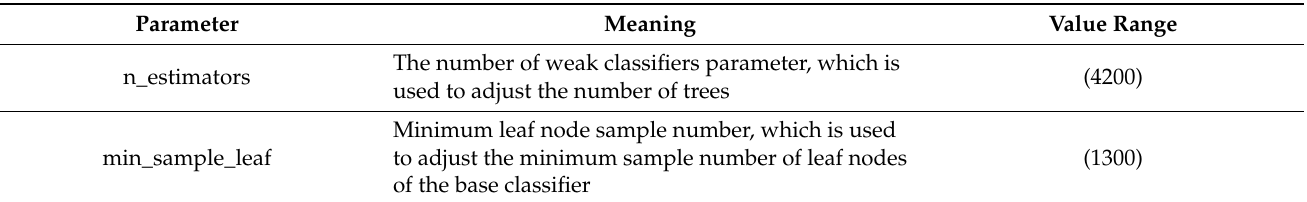
Table 1. RF parameter: n_estimators and